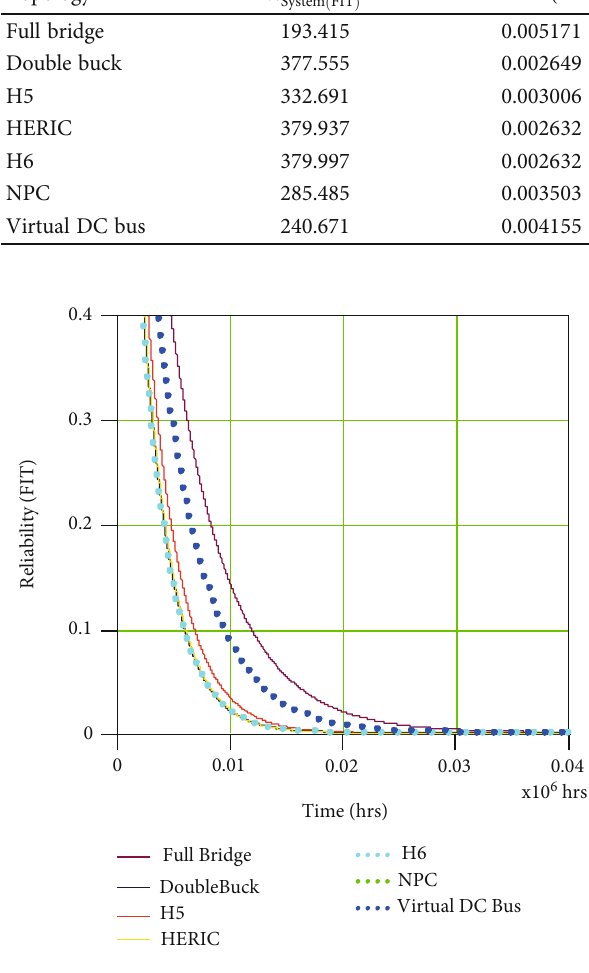
Figure 12: Comparative graph of the reliability of single-phase inverters.